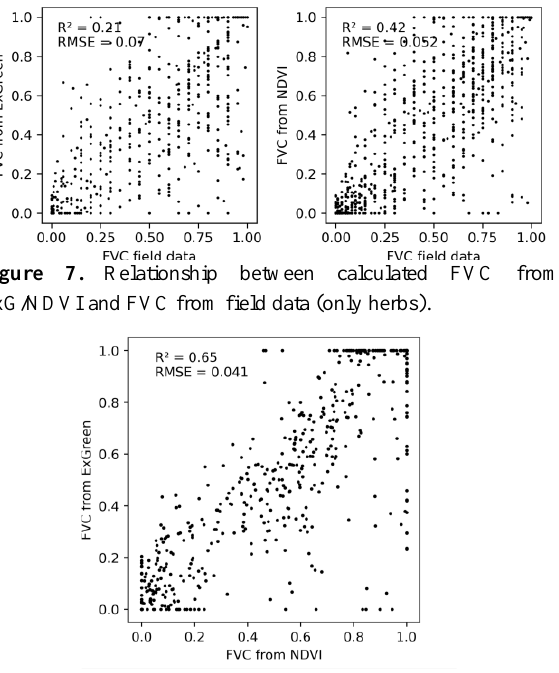
Figure 8. Relationship between FVC calculated from NDVI and FVC calculated from